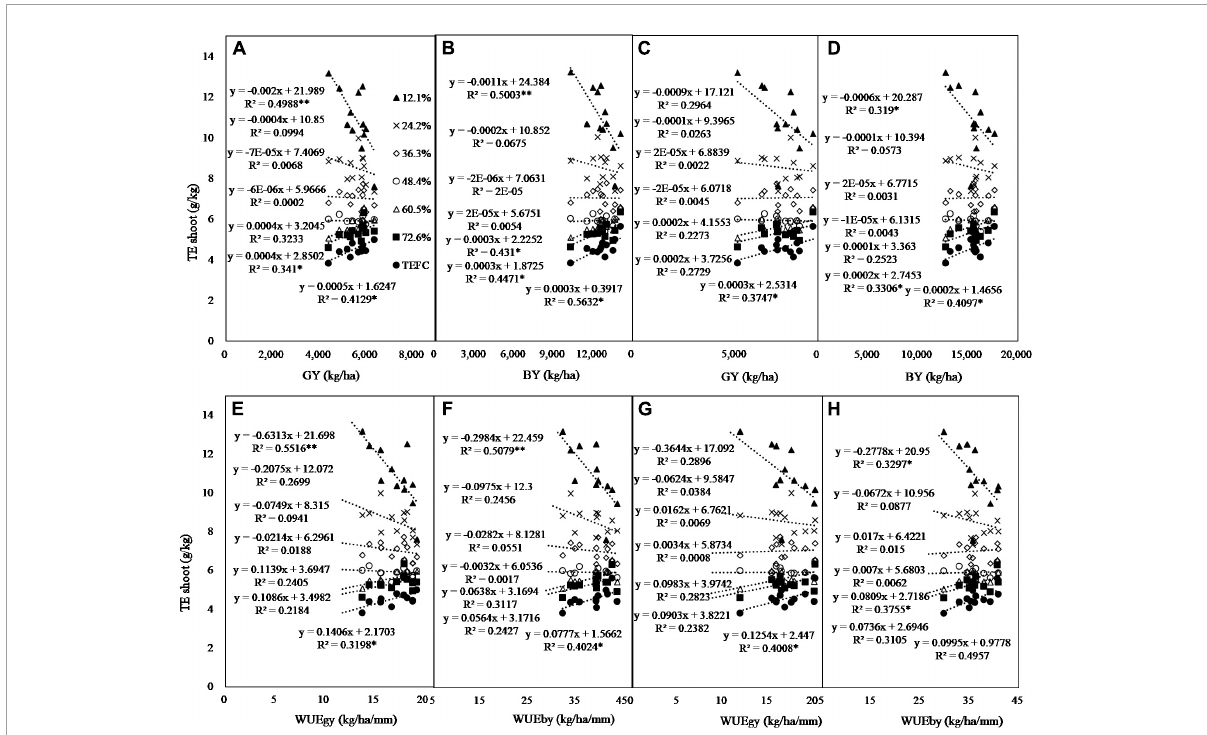
FIGURE8 The regression of pot TE shoot to yield ( GY , grain yield; BY , biomass yield) and water use efficiency ( WUE gy , WUE at grain yield level; WUE by , WUE at biomass level) under rain-fed (A,B,E,F) and twice irrigation (150 mm, C,D,G,H ). TE FC , TE measured at field capacity, *, ** means significant at the P = 0.05 and P = 0.01 levels, respectively.